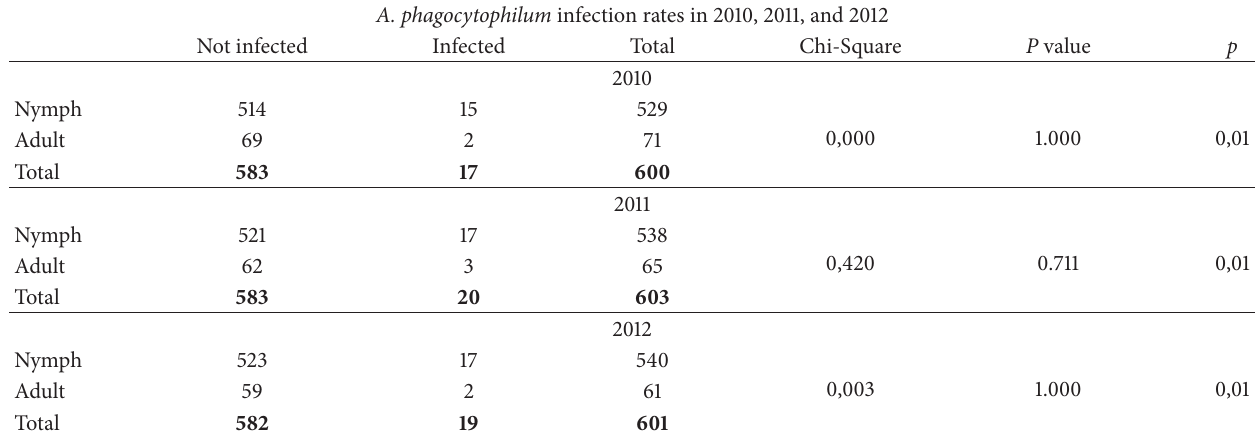
Table 1: Statistical analysis of the infection rates in nymphs and adult female